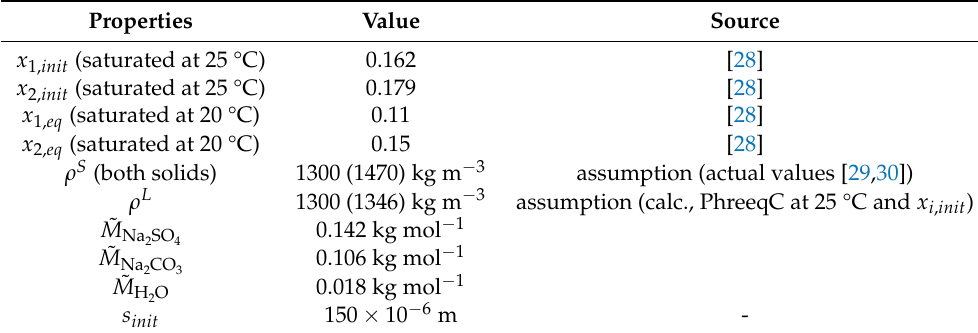
Table 1. List of physico-chemical properties used in the simulations. Mass fractions are given with respect to ternary solubility at given